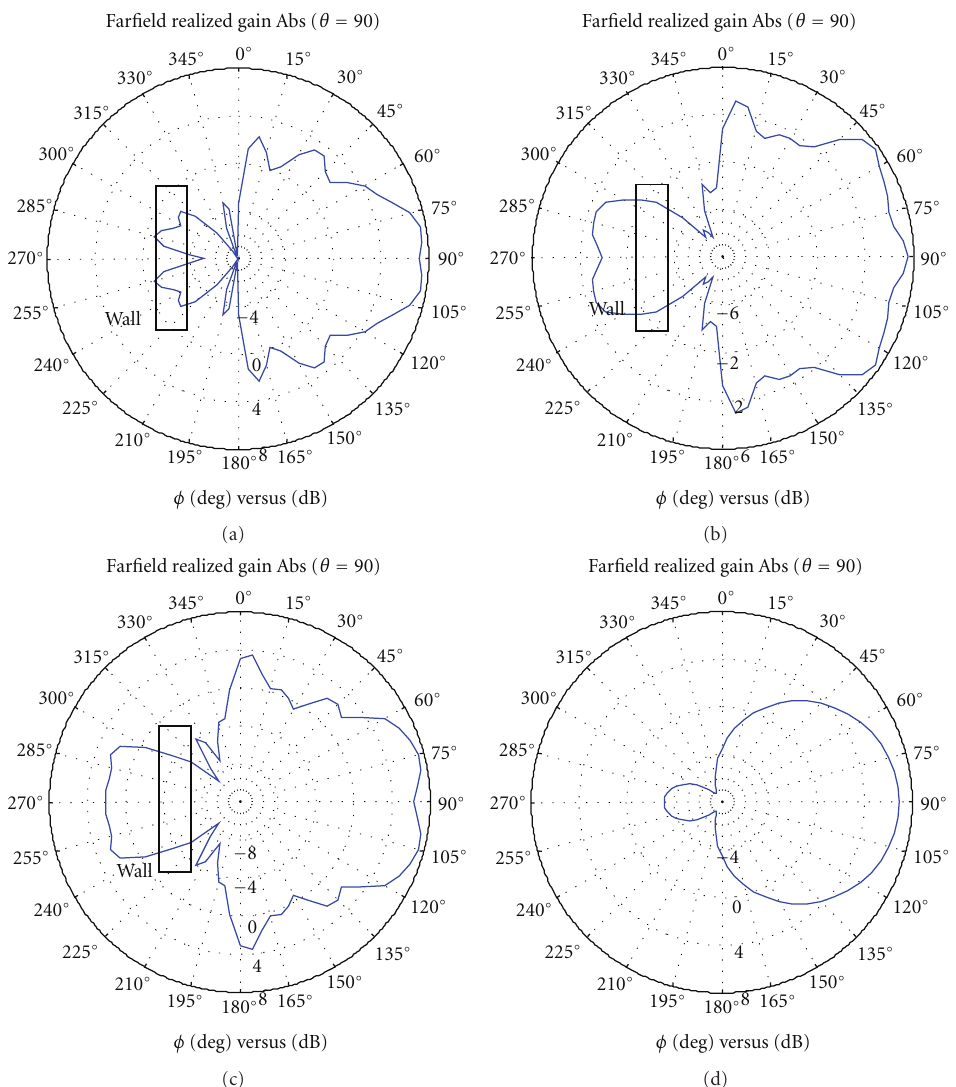
Figure 6: Power gain in azimuth in the parallel case. (a)–(c): wall distance 50mm, 100 mm, and 150 mm; (d) isolated antenna (1.9